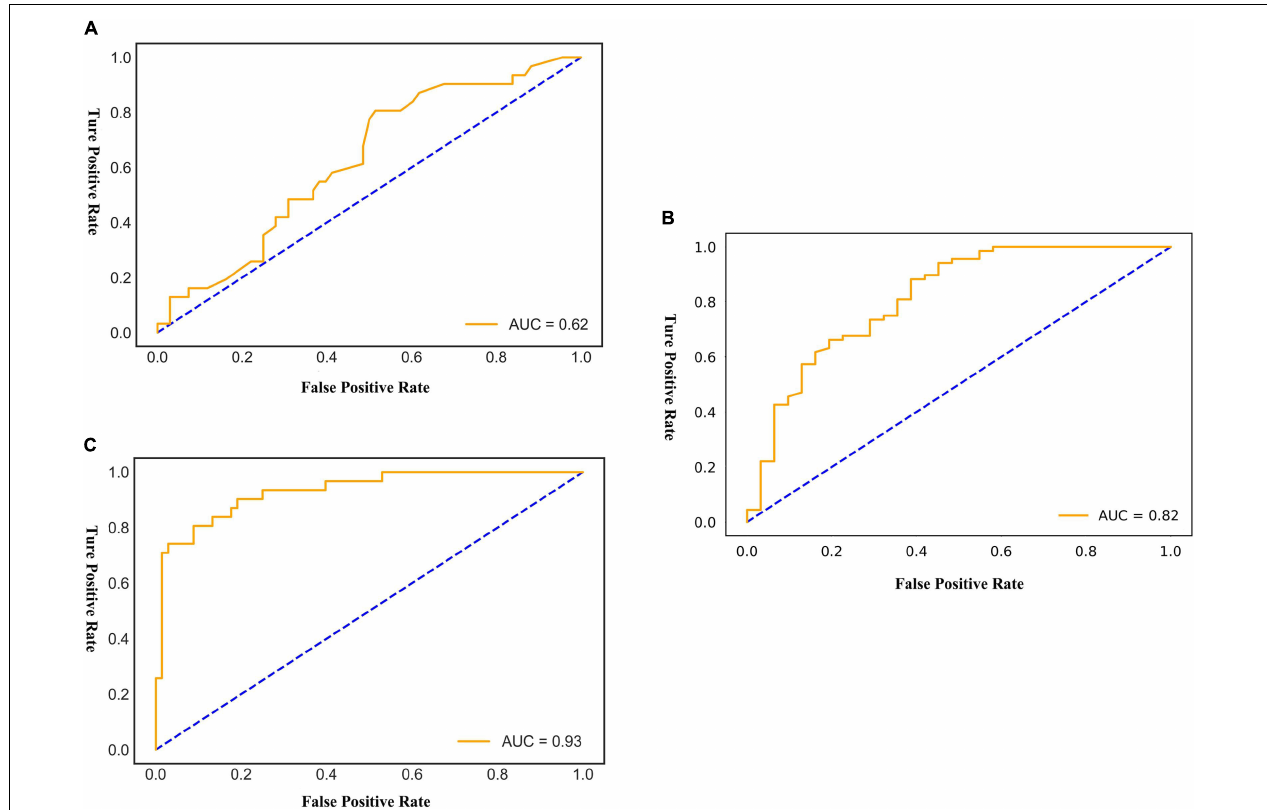
FIGURE 4 | The AUC of the multimodal models for predicting EVAR-related SAEs in the test set. AUC, area under the curve; SAEs, severe adverse events; EVAR, endovascular aneurysm repair. (A) AdaBoost ROC curve with test dataset. (B) Fold 3 ROC curve with test dataset. (C) LogisticRegression ROC curve with test dataset.